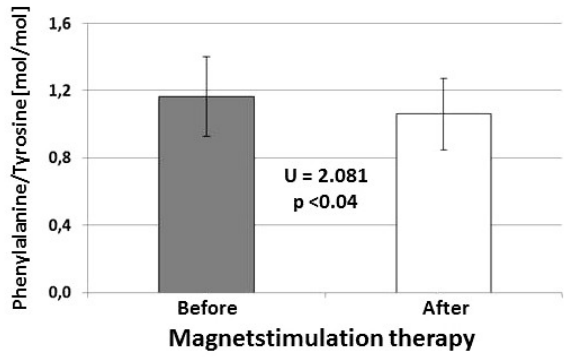
Figure 2: Phenylalanine/Tyrosine (Phe/Tyr) ratio before and after a series of ten rTMS sessions, indicating a significant decline which may correspond to an increase of phenylalanine hydroxylase activity (Mean values ± SD are shown).